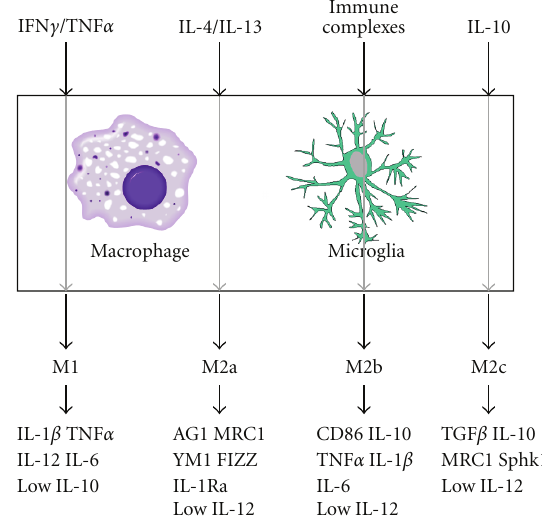
Figure 1: Schematic illustrating the M1, M2a, M2b, and M2c macrophage inflammatory